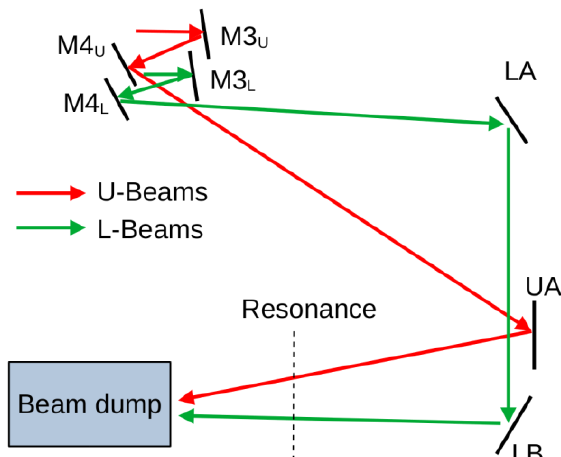
Fig. 1. Beam path of the from the launcher to the beam dump